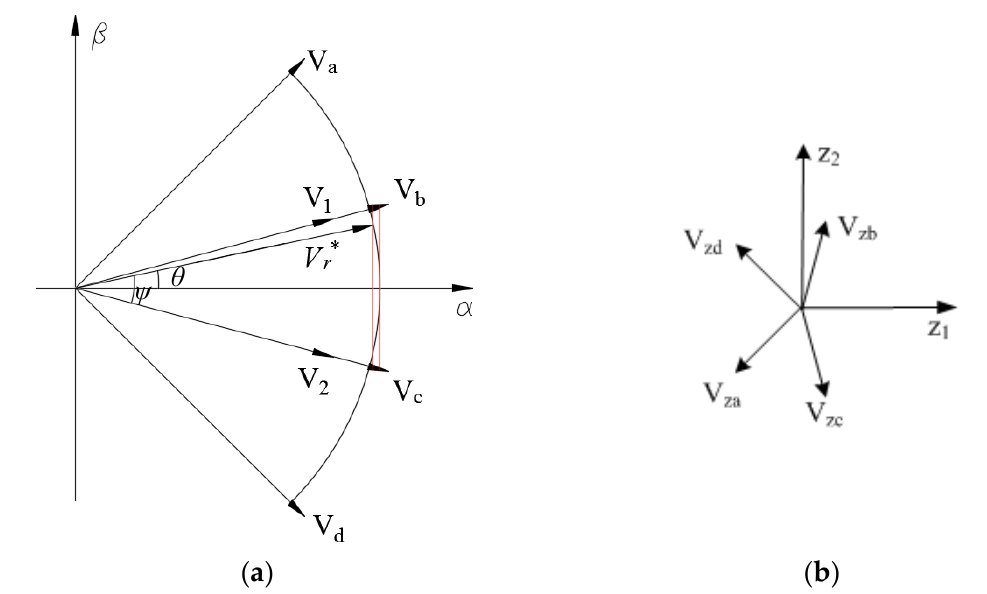
Figure 3. Diagram of voltage vectors for the TFOS strategy: ( a ) α − β subspace and ( b ) Z 1 − Z 2 subspace.